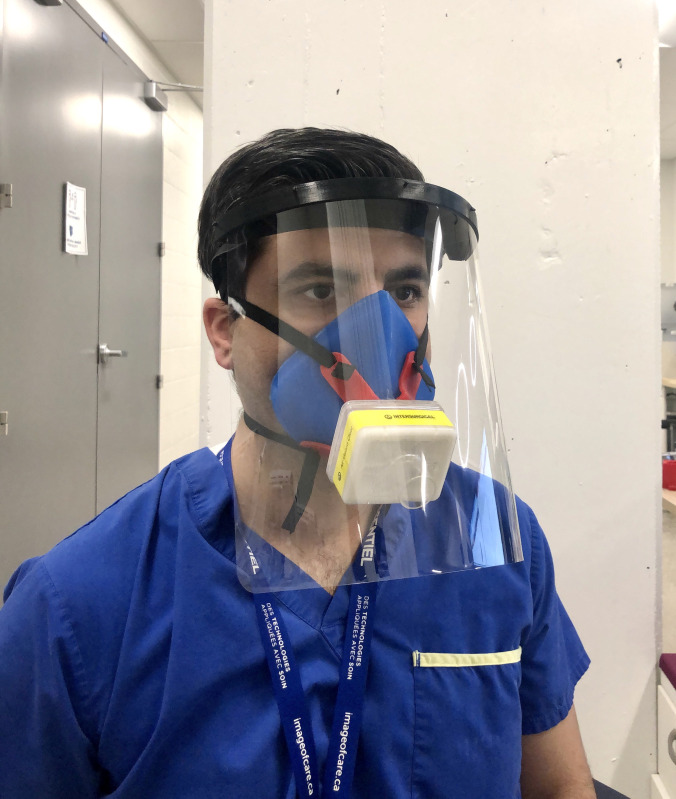
The SSM respirator is worn with a face shield.